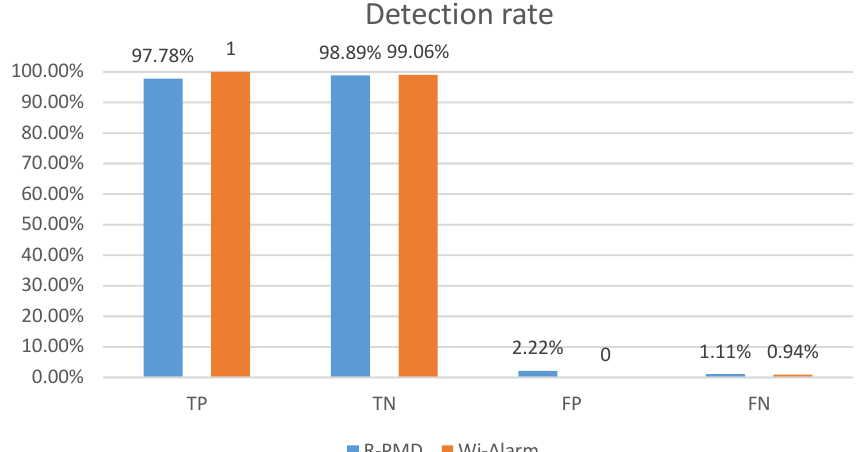
Figure 10. Detection rates of two systems.